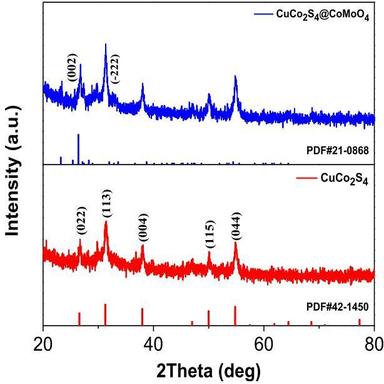
XRD patterns of CuCo2S4 and CuCo2S4@CoMoO4 compounds.